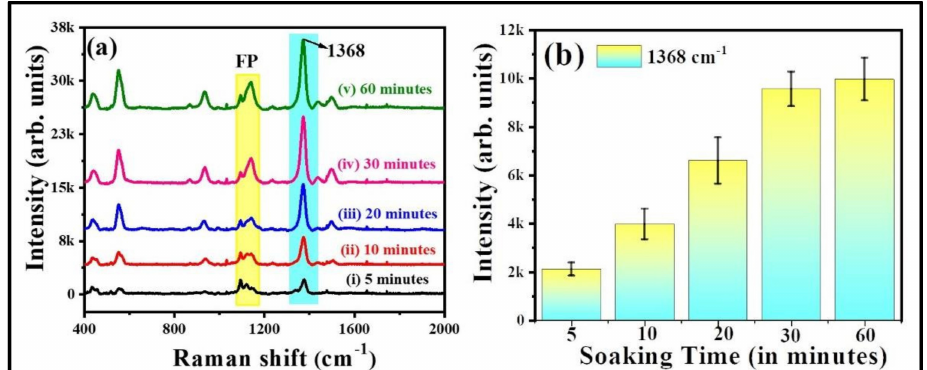
Figure 7. ( a ) Soaking time of filter paper in Au NPs ( b ) relative intensity of thiram (50 µ M) at 1368 cm − 1 with respect to FP soaking time. Error bars are measured based on the standard deviation of the average SERS intensity at 1368 cm − 1 peak accomplished by repetitive SERS measurements five times. Integration time is 30 s.